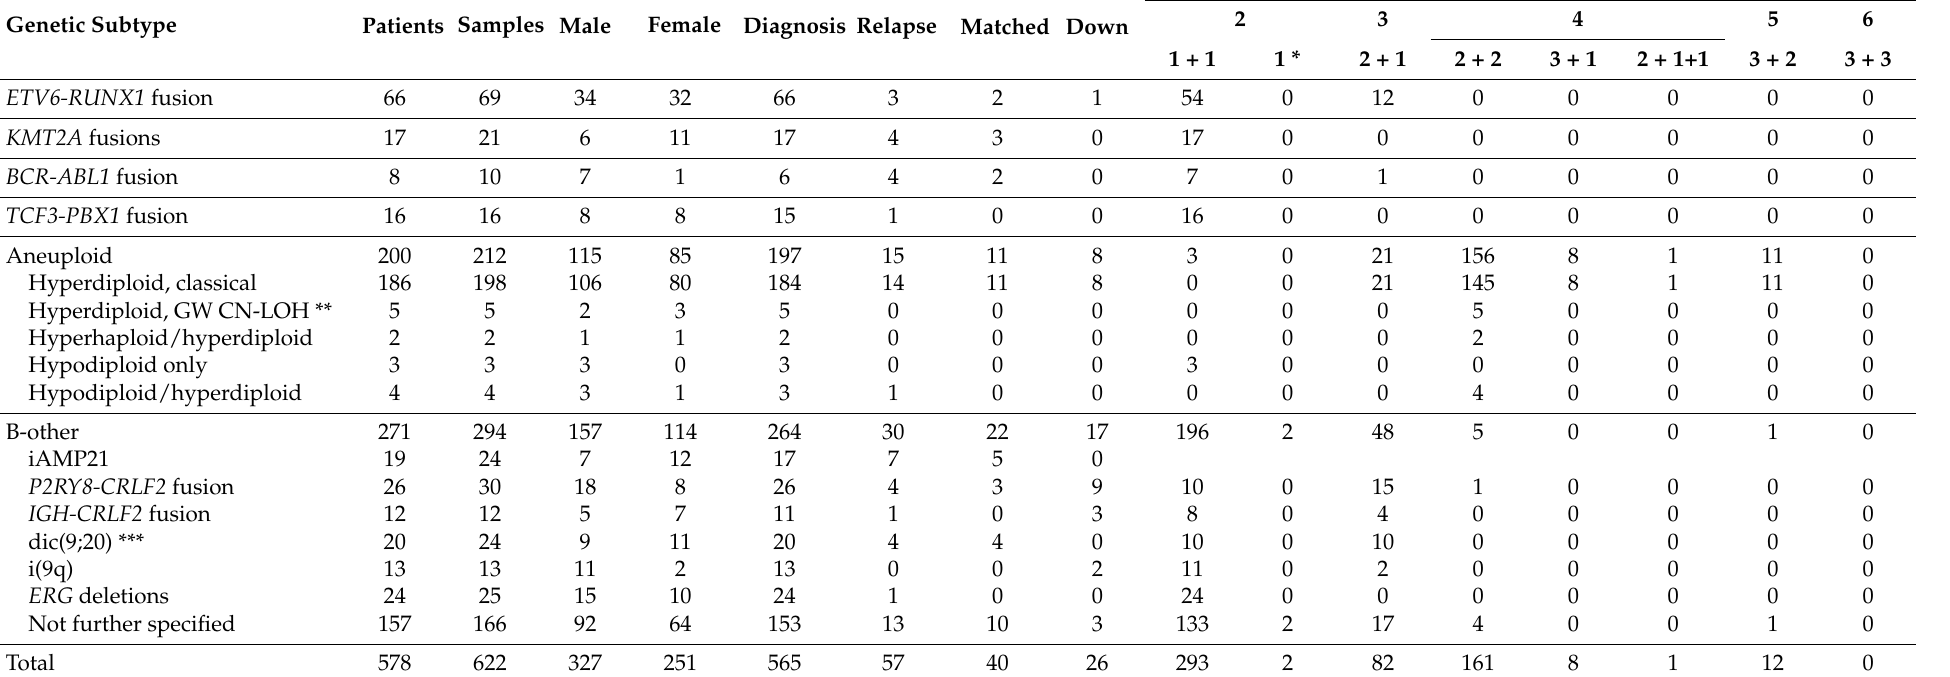
Table 1. Summary of all the types of copy number abnormalities and allele distribution patterns that we identified in 578 children with various ALL subtypes.